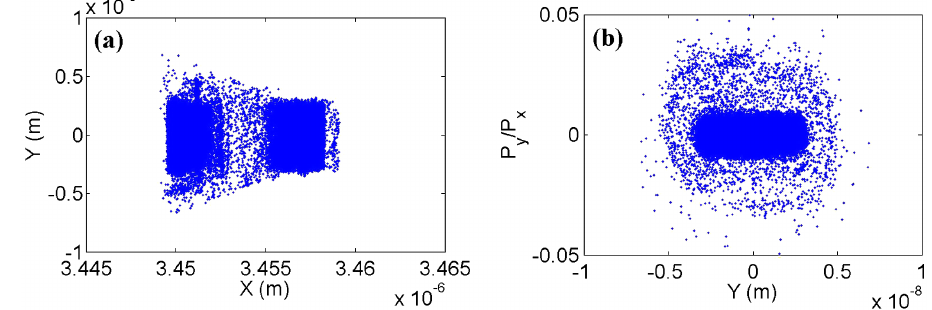
FIG. 5. (a) The accelerated electron beam quality in the x-ray wakefield in a tube. The space distribution ( x , y ) and (b) the transverse phase space ( y , p y =p x ) of the top 30% highest energy electrons in the case of x-ray laser. The parameters are the same as in Fig. 4.